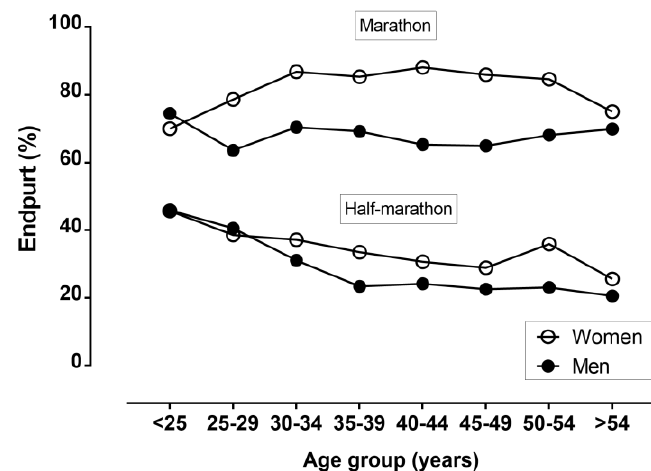
Figure 2. Variation of end spurt by gender, race distance, and age groups.